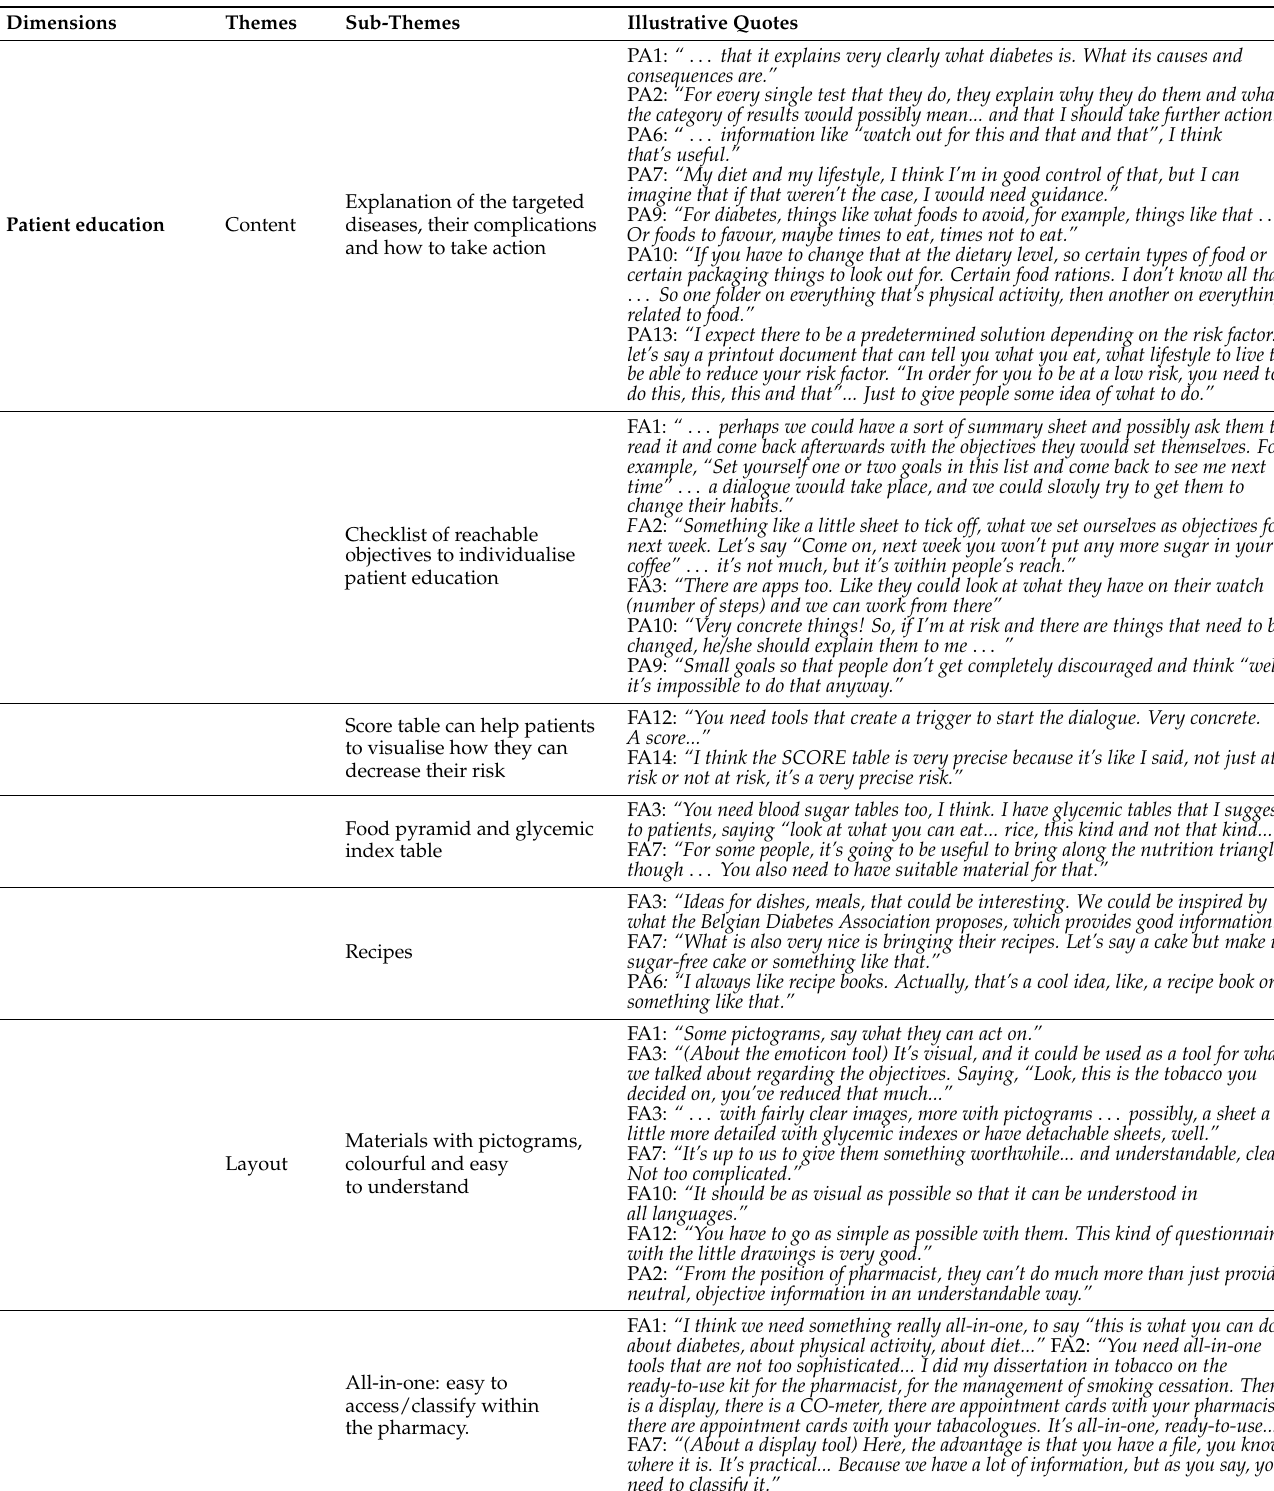
Table A1. Themes emerging from the qualitative analysis of the patients’ interviews and pharmacists’ focus